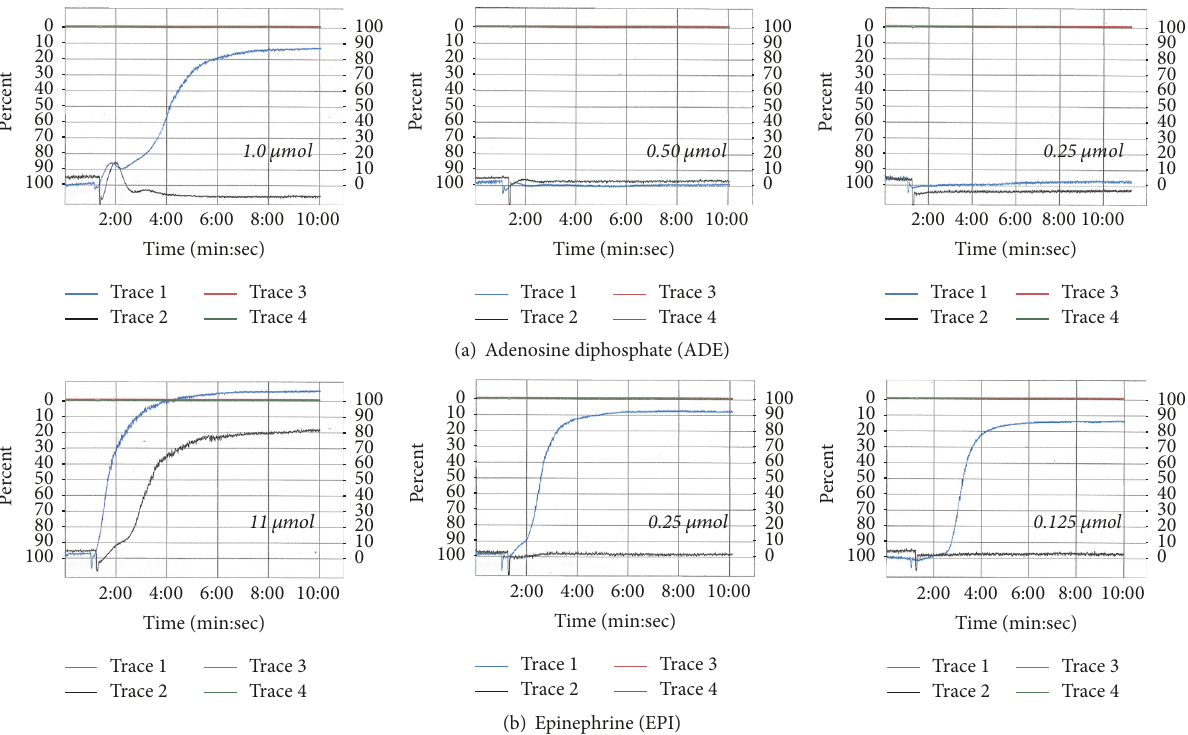
Figure 4: Results of two platelet aggregometry tests: patient (blue line) and control (black line). (a) From left to right, the percentage of platelet aggregation with decreasing doses of ADE is shown. At 1 𝜇 mol, the patient presents platelet aggregation of almost 90% at 10 min. At lower concentrations of ADE, the pattern of aggregation is similar to that of the control (0.5 and 0.25 𝜇 mol). (b) From left to right, the percentage of platelet aggregation with decreasing doses of EPI is shown. At 11 𝜇 mol, the patient and control present platelet aggregation that reaches more than 80% at 10min. In contrast to lower concentrations of EPI, while the control stops having platelet aggregation, the patient maintains a pattern of aggregation above 80% at concentrations of 0.25 and 0.125 𝜇